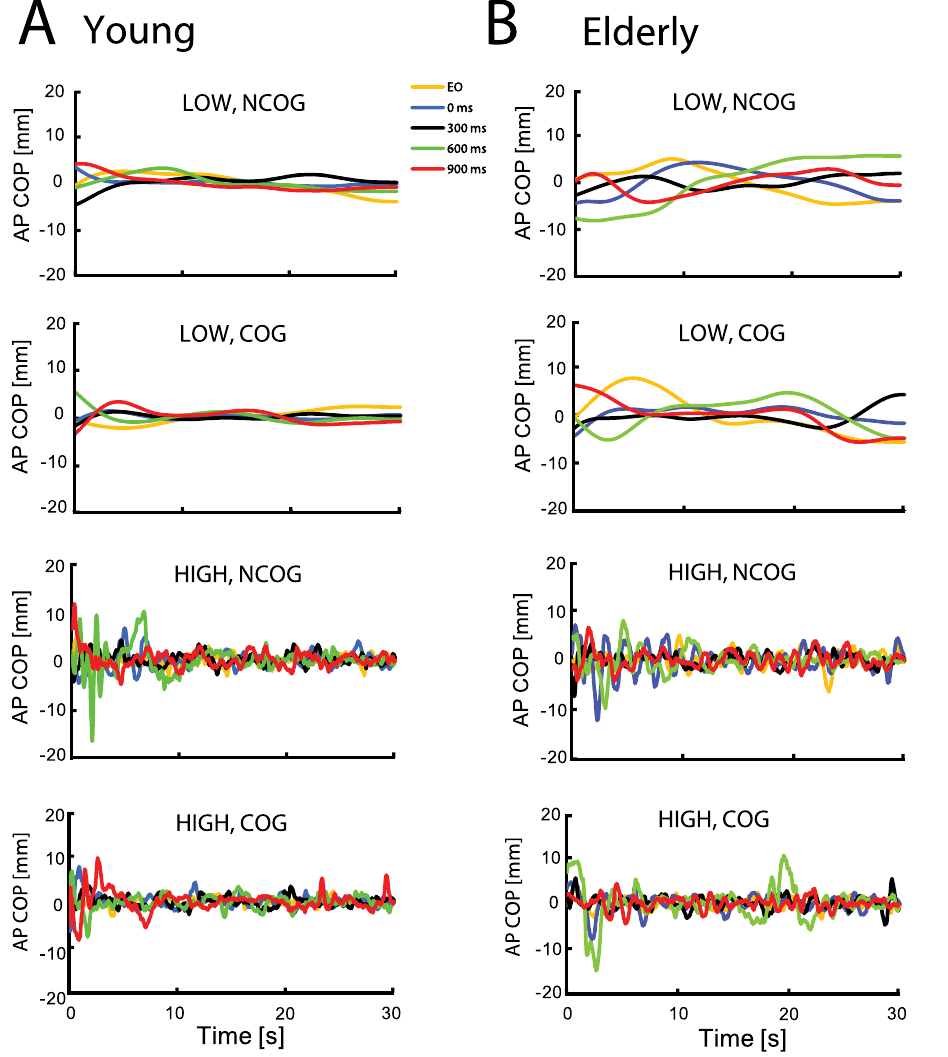
Figure 4. High and low-pass filtered anteroposterior (AP) COP displacements in delayed visual feedback and cognitive dual-task conditions. A. Representative low (LOW) and high-pass filtered (HIGH) AP COP time series from a single trial performed by a representative young participant in the visual feedback conditions with (COG) or without (NCOG) performing the simultaneous mental arithmetic task (Yellow: EO; Blue: 0 ms delay; Black: 300 ms delay; Green: 600 ms delay; Red: 900 ms delay). B. Same format as in A but from a single trial performed by a representative older participant.